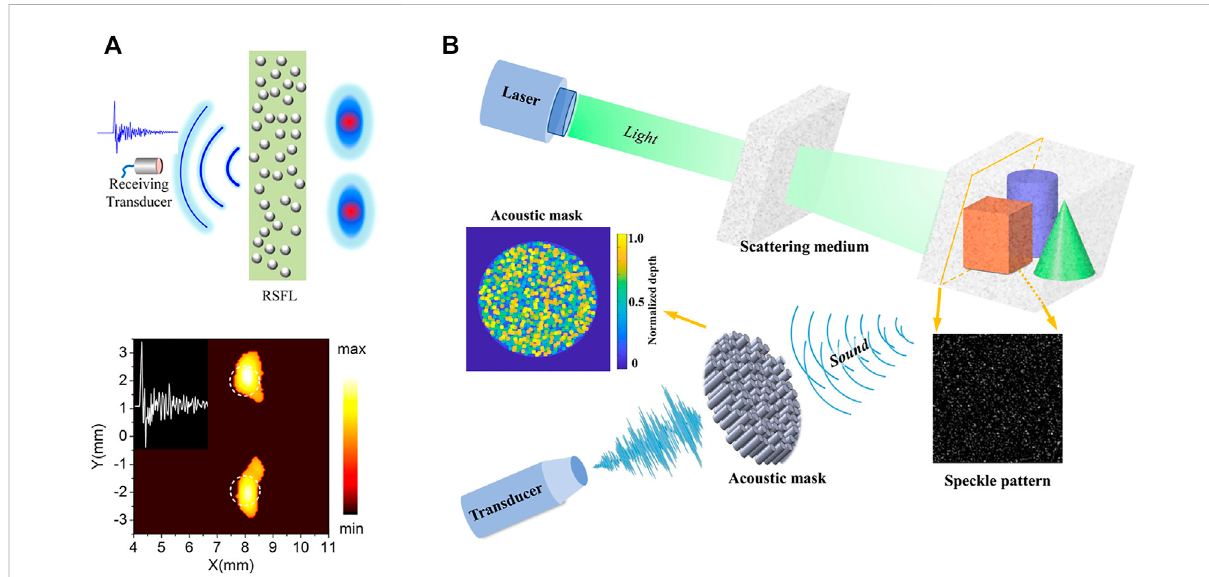
FIGURE 6 Single-detectorphotoacousticimagingwith scattering media. (A) Dynamicfocusing ofacoustic waveutilizing arandomlyscatteringlens anda single fi xed transducer [117]. (B) Single-shot compressed photoacoustic tomographic imaging with a single detector in a scattering medium [118]. Figure reproduced with permission from: (A) , © 2017, AIP Publishing; (B) , © 2020, American Physical